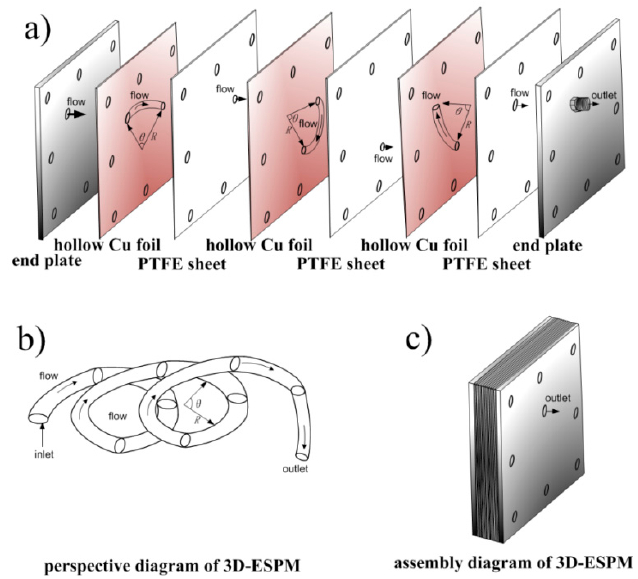
Figure 2. Schematic diagram of the 3D-ESPM. ( a ) Assembly diagram, ( b ) perspective diagram, ( c ) assembled diagram.